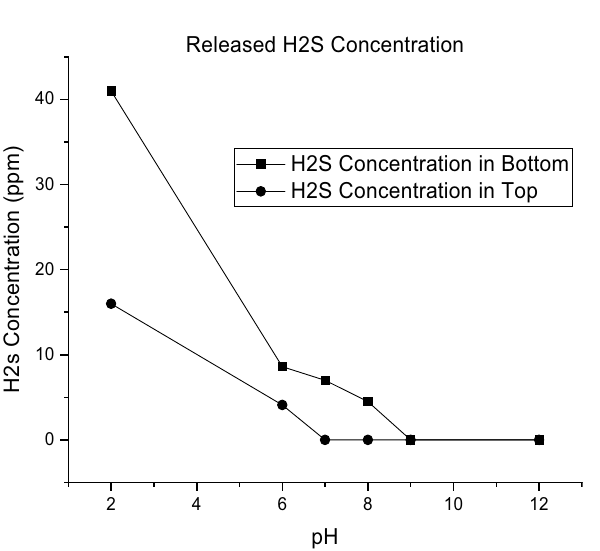
Figure 6. Released H2S concentration after the addition of sodium sulfide at various pH